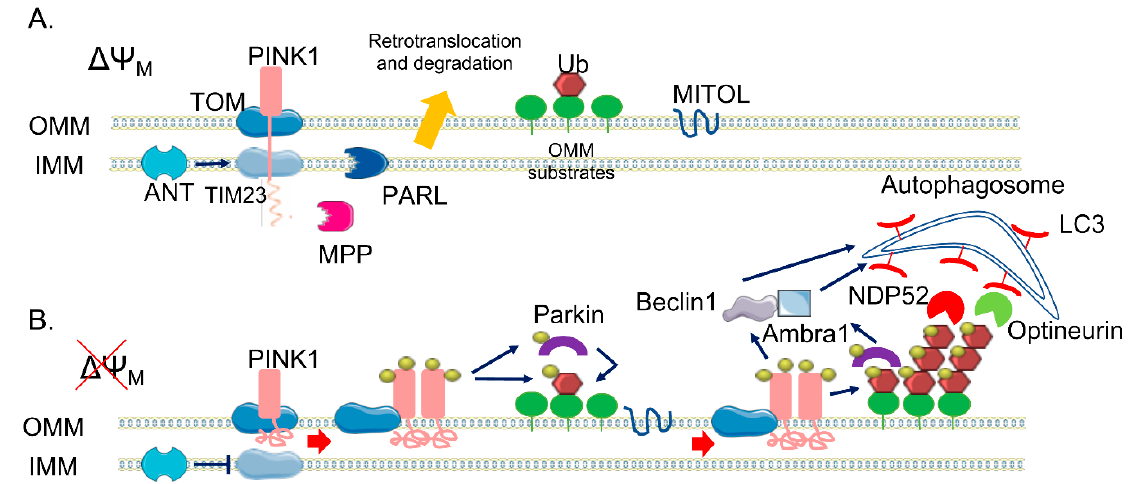
Figure 1. The canonical phosphatase and tensin homolog (PTEN)-induced kinase 1 (PINK1) / Parkin pathway. ( A ) In healthy mitochondria, PINK1 is constitutively imported via translocase of the outer membrane (TOM) / translocase of the inner membrane (TIM)23 complexes to the inner membrane (IMM), cleaved by two proteases (mitochondrial processing peptidase (MPP) and presenilin-associated rhomboid-like (PARL)) and retro-translocated to the cytosol, where it is degraded. ( B ) When ∆Ψ M is dissipated, Adenine nucleotide translocator ANT inhibits TIM23-mediated import of PINK1, which is not processed and accumulates on the outer membrane (OMM). Here, a supercomplex is formed, composed by TOM complex subunits and PINK1 homodimers, facilitating PINK1 autophosphorylation and activation. Once activated, PINK1 phosphorylates ubiquitinated substrates on the OMM and thus recruits and phosphorylates Parkin. Phosphorylated Parkin starts to ubiquitylate several proteins on the OMM, which are new substrates of PINK1 phosphorylation—a positive feedback loop is initiated, leading to the coating of damaged mitochondria with phospho-ubiquitin chain, red arrows. The MITOL mitochondrial E3 ubiquitin ligase, seems to be fundamental for the introduction of the initial ubiquitination. Phospho-ubiquitin chains are bound by two mitophagy adaptors, Nuclear domain 10 protein 52 (NDP52) and Optineurin, blue arrows. The two adaptors recruit autophagosomes via Microtubule-associated protein 1A / 1B-light chain 3 (LC3) binding, allowing the engulfment of dysfunctional mitochondria. In parallel, PINK1 interacts with Beclin-1 and Parkin with Ambra1, further stimulating autophagosome formation, blue